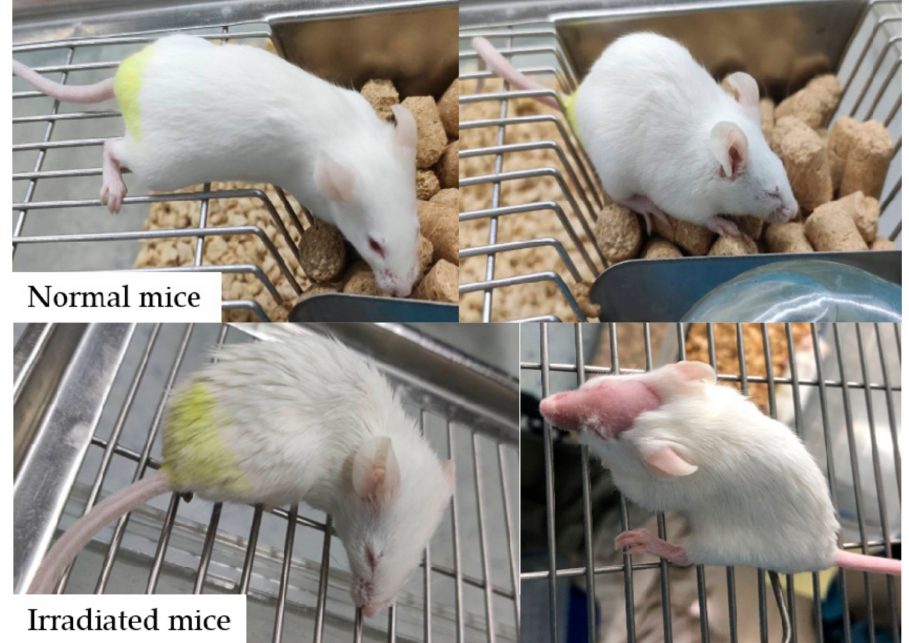
Figure 3. General status of normal mice and irradiated mice.